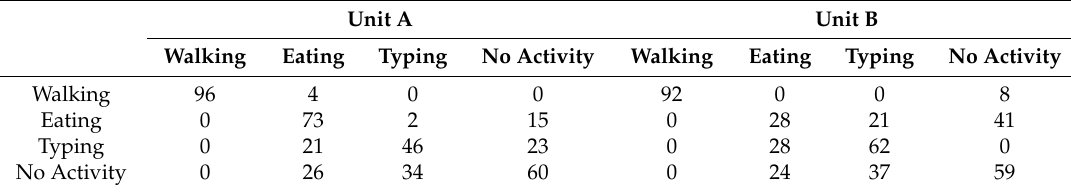
Table 2. Confusion matrix for Unit A and Unit B using EMD-based